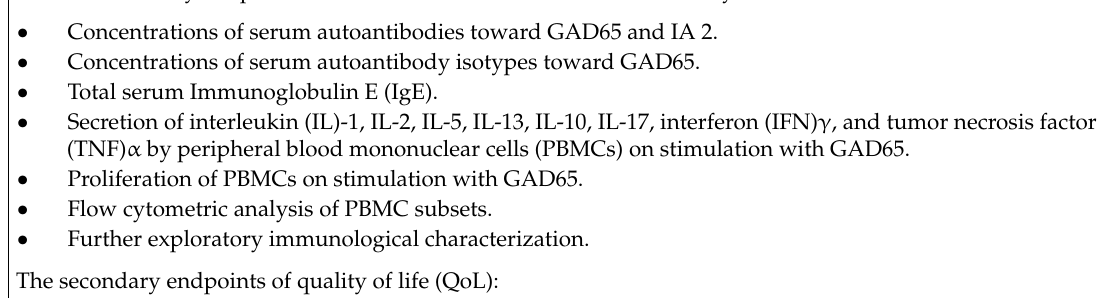
Box 2. Secondary endpoints in a clinical trial (DIAGNODE-2) evaluating the e ffi cacy of intra-lymphatic autoantigen treatment of type 1